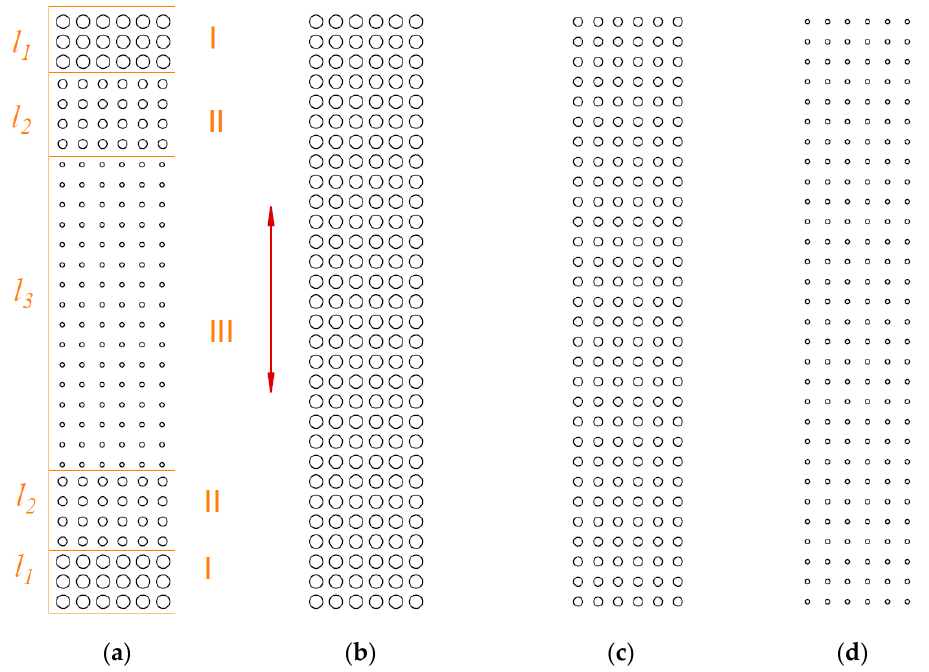
Figure 25. Different dimple patterns on the cylinder liner surface ( a ) surface texture with pit area ratios Sp and the dimple depth over diameter ratios e in different regions (in region I Sp = 19%, e = 0.1, in region II Sp = 16%, e = 0.09 and in region III Sp = 11%, e = 0.08 ( b ) surface texture with Sp = 19%, e = 0.1 ( c ) surface texture with Sp = 16%, e = 0.09, ( d ) surface texture with Sp = 11%, e = 0.08; l 1 = 16,2 mm, l 2 = 25.2 mm, l 3 = 97.2 mm, after [135].